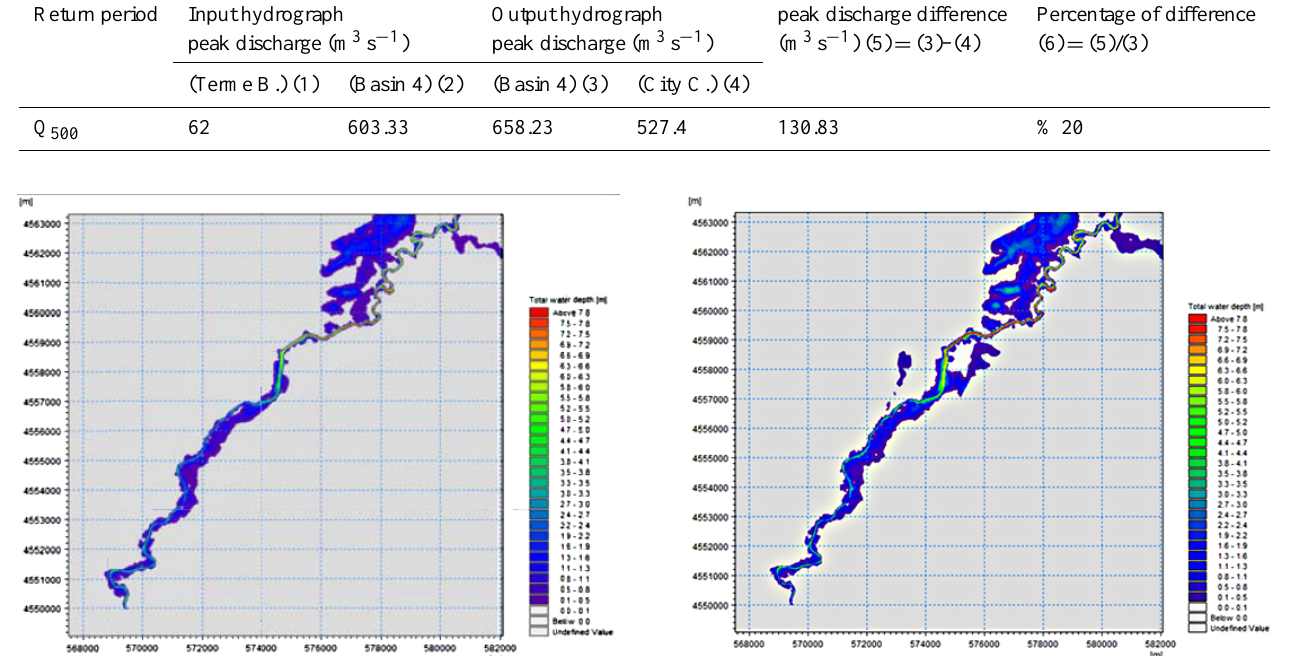
Figure 3. Q 500 flood water depth. (a) Scenario 1, (b) Scenario 2.